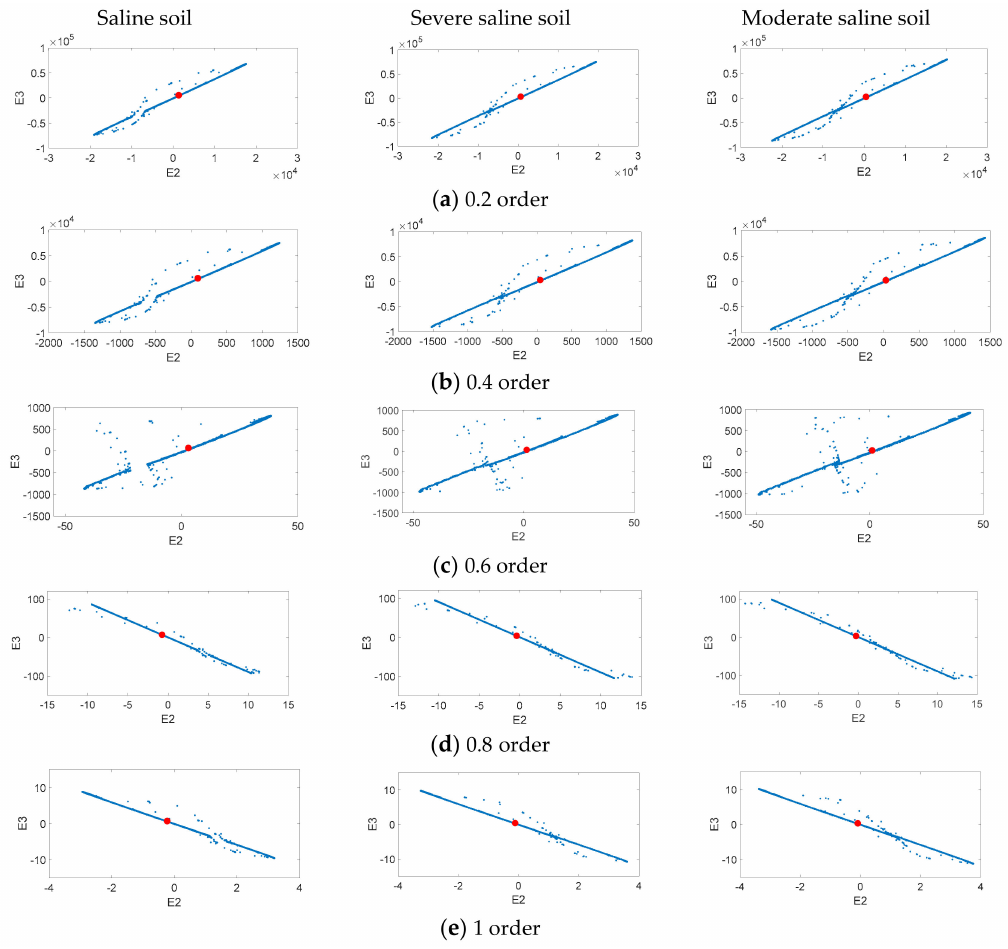
Figure 9. Area B’s chaotic dynamic error distribution.